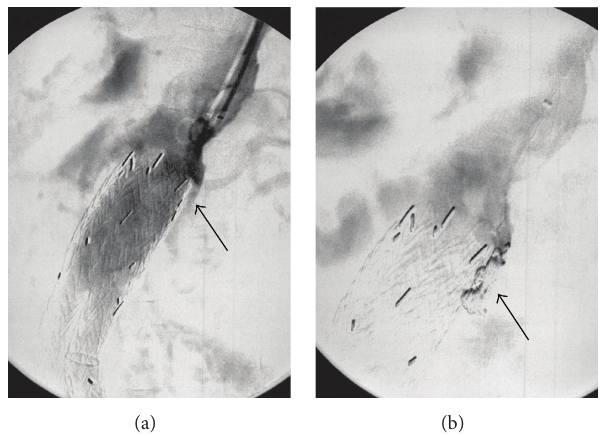
Figure 2: (a) Intraoperative angiography showed the origin of the type Ia endoleak (black arrow). (b) Intraoperative angiography after coil embolization showed the disappearance of the origin of type Ia endoleak (black